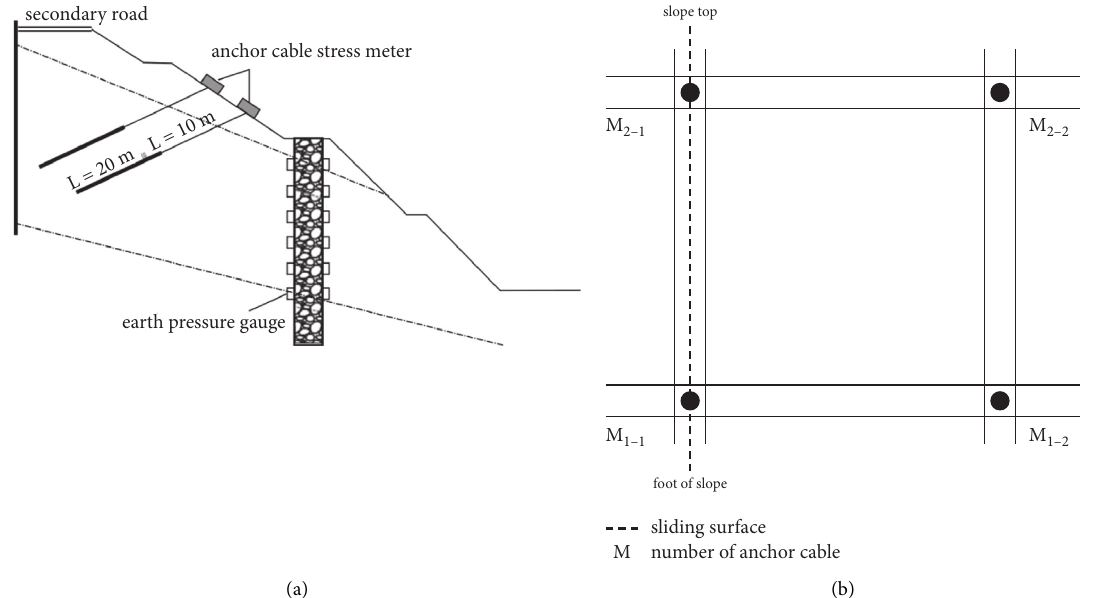
Figure 12: Monitoring point layout section of pile anchor composite structure. (a) Layout of earth pressure gauge. (b) Anchor cable number and layout plan.